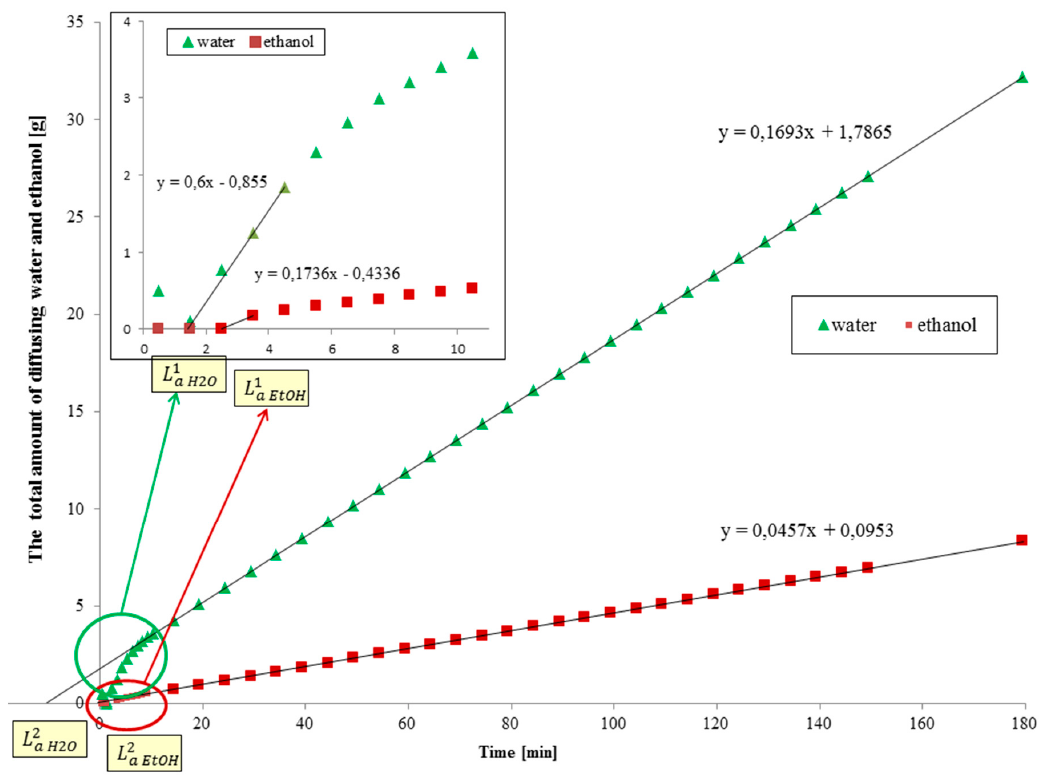
Figure 6. The total amount of diffusing water and ethanol separately versus time. The graphical